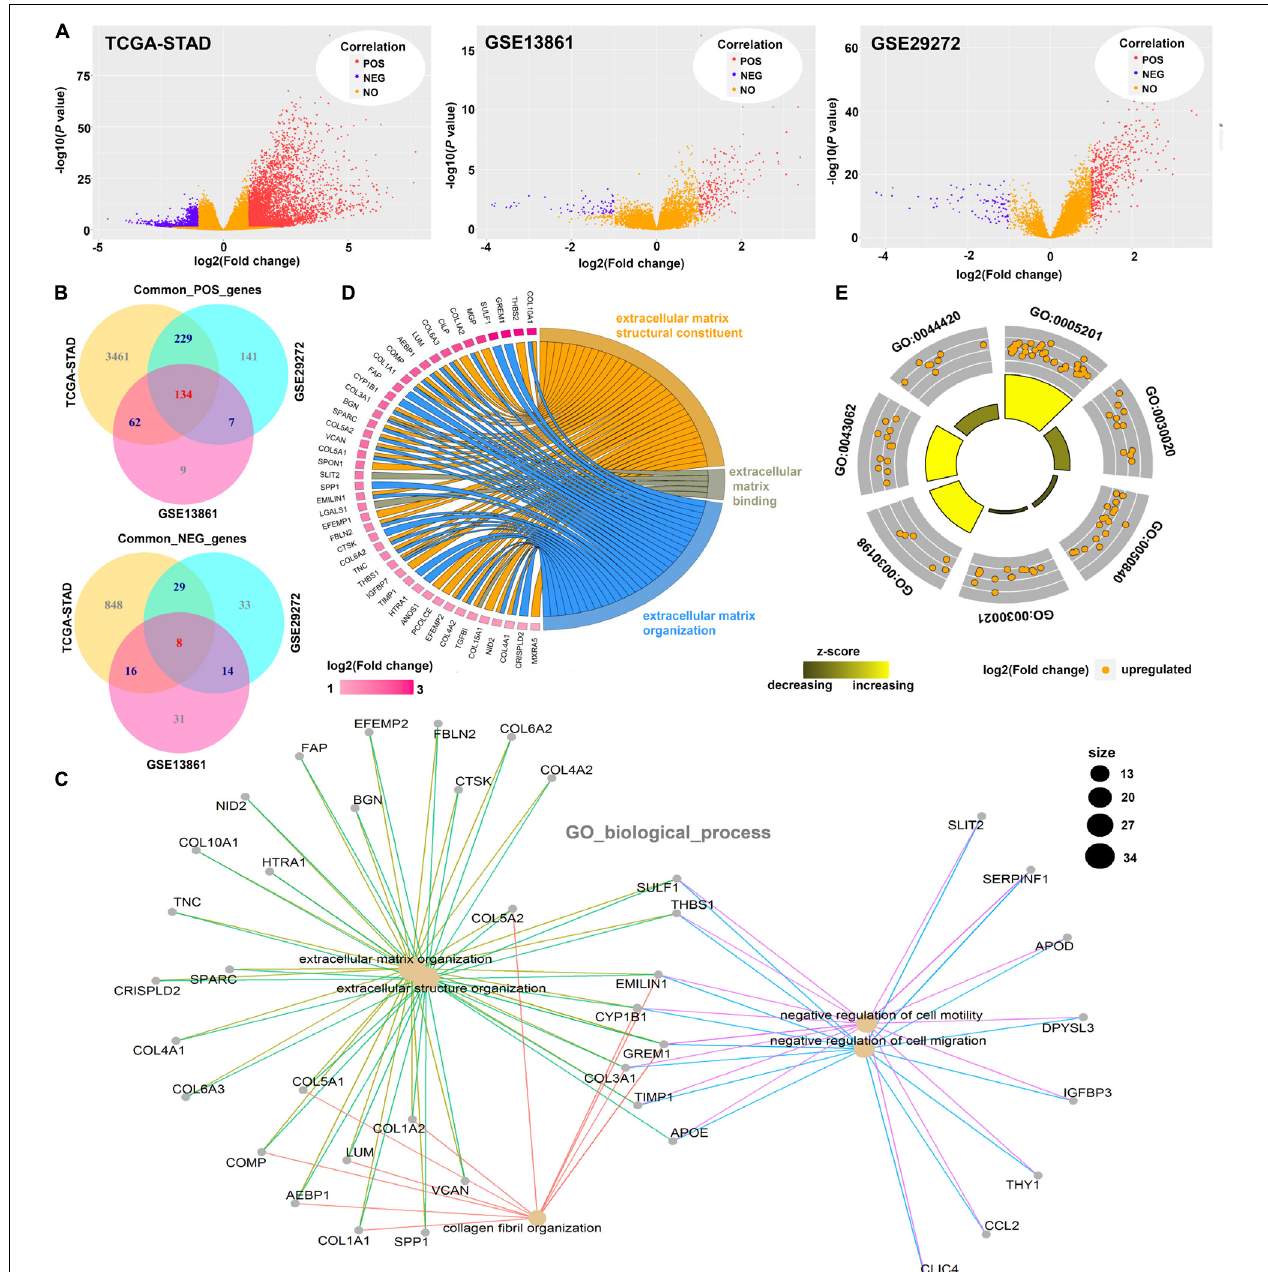
FIGURE 7 | Cluster analysis of significant ISLR -correlated genes. (A) After expression difference analyses between the ISLR-high and -low expression groups were performed with the “limma” R package on the TCGA-STAD, GSE13861, and GSE29272 datasets, volcano plots were constructed. POS, genes positively correlated with ISLR ; NEG, genes negatively correlated with ISLR ; NO, genes not correlated with ISLR . (B) The “VennDiagram” R package was used for the common genes positively (POS) and negatively (NEG) correlated with ISLR. (C) The “clusterProfiler” R package was used for the GO_biological_process enrichment analysis. The GOCircle (D) and chord plots (E) using extracellular matrix-associated terms were visualized by the “GOplot” R package.